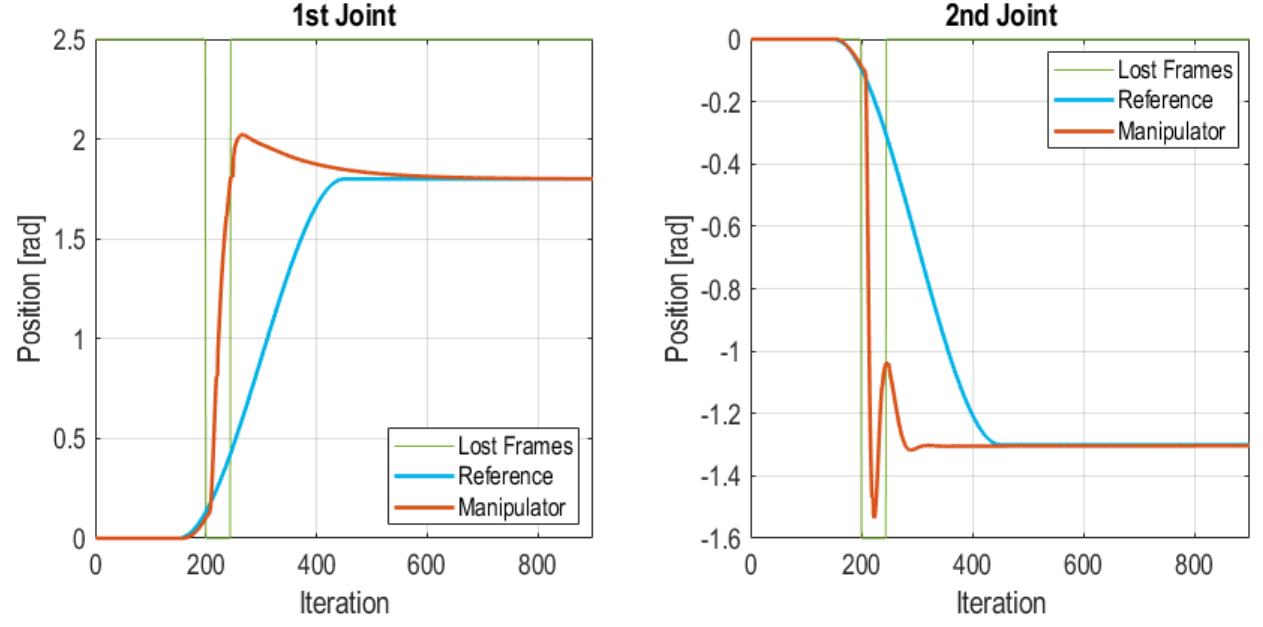
Figure 14. Burst of frames lost at start of the transitory state.